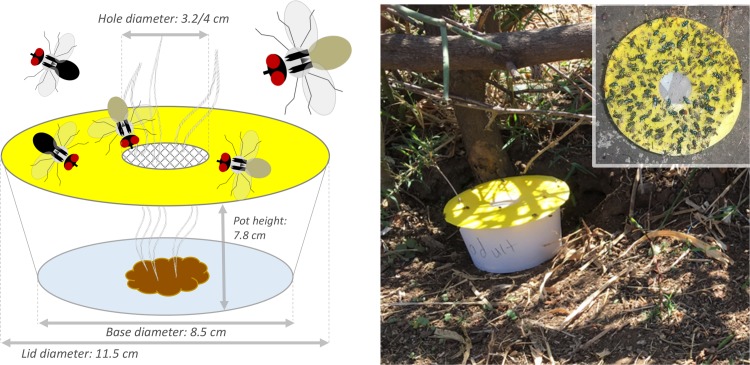
‘Bristow Trap’—an odour-baited trap for Musca sorbens.(A) Trap design and dimensions (hole diameter used in the two studies was different; Gambian study 3.2 cm, Ethiopian study 4 cm) (B) A fly trap ‘in situ’ in Ethiopia; (insert) typical fly catch on the yellow sticky discs on the trap.